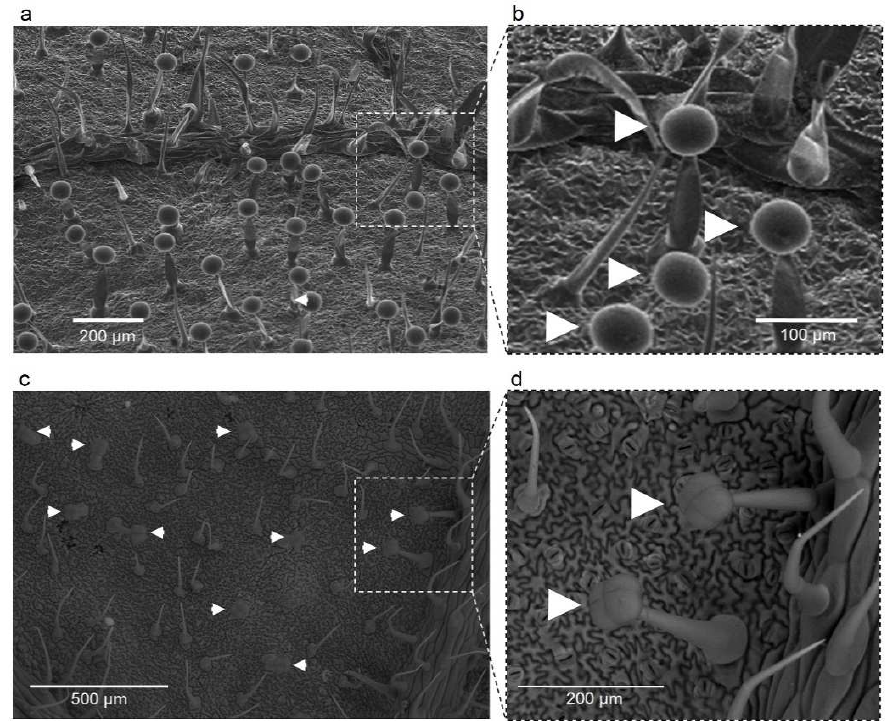
Figure 2. Type IV ( a , b ) and type VI ( c , d ) glandular trichomes present in leaflets of tomato genotypes with high zingiberene contents.